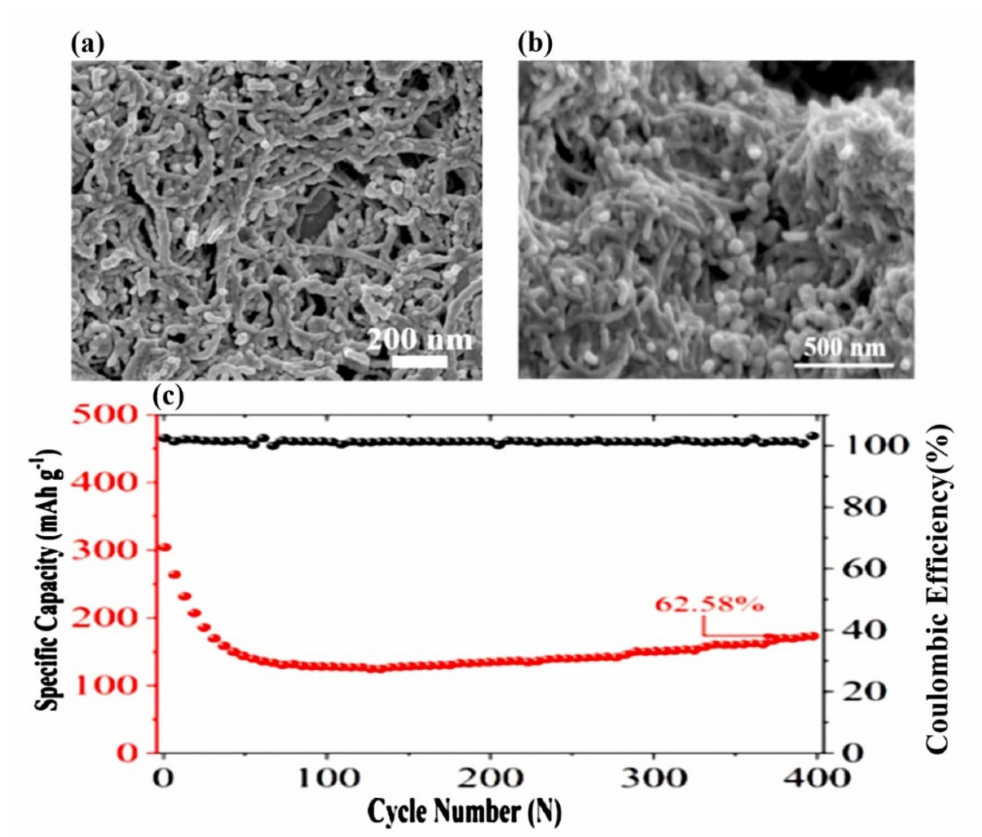
Figure 8. ( a ) SEM image of the Se-CNTs@NiSe nanocables, ( b ) SEM images after long-term cycling, and ( c ) cycling performance at 0.1 A g − 1 of the Se-CNTs@NiSe-700 nanocables used as anode materials for LIBs. Reproduced with permission from [71], Copyright 2021, Elsevier